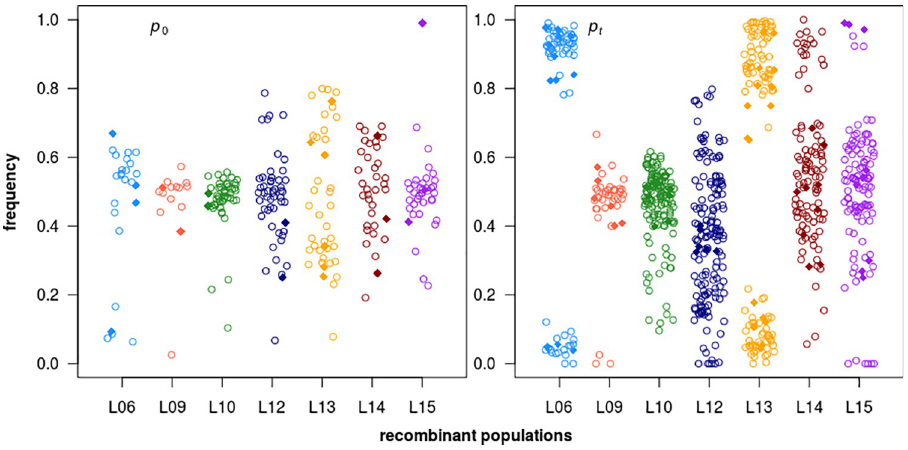
Fig 2. Mutation frequencies at the start ( p 0 ) and the end ( p t ) of experimental evolution of the seven recombinant populations. Mutational types are indicated with symbols: open circles—SNPs, closed diamonds—Indels.